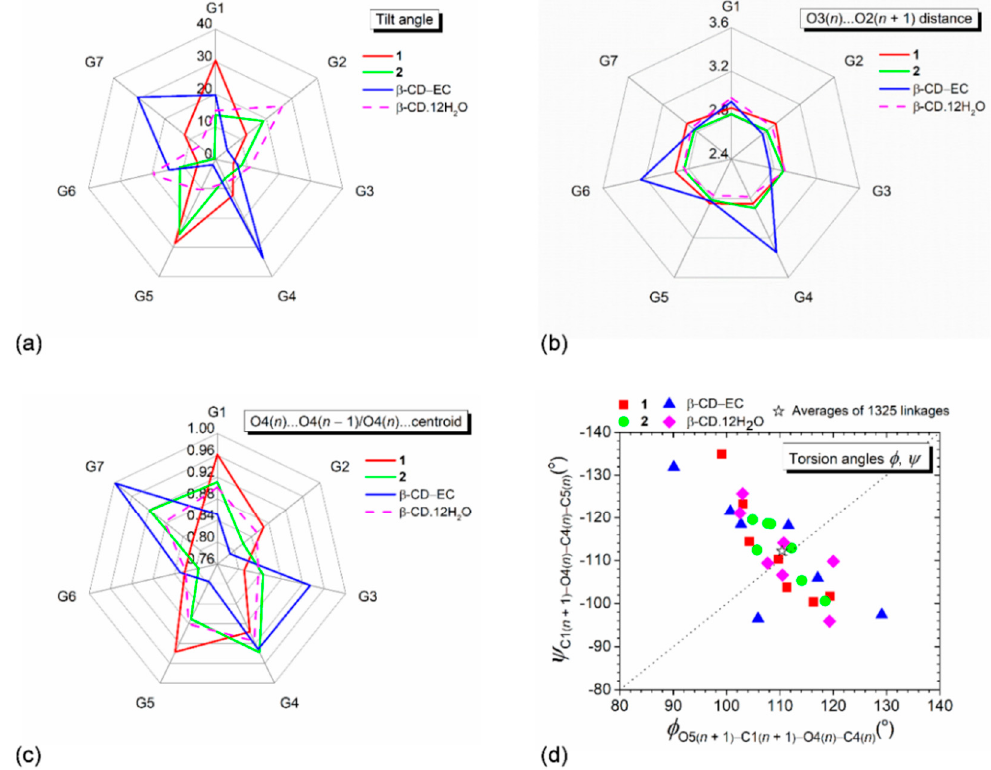
Figure 5. Radar plots of ( a ) tilt angles, ( b ) O3( n )···O2( n + 1) distances, and ( c ) O4( n )···O4( n − 1)/O4( n )···centroid distance ratios of the β -CD seven glucose units (G1–G7) affected by the inclusion of the aromatic moieties of the PRT B-ring ( 1 ) and the MPL A-ring ( 2 ). ( d ) Scatter plot of torsion angles φ , ψ around glycosidic O4. Data of the inclusion complex β -CD–(–)-epicatechin (EC) [44] and the uncomplexed β -CD·12H 2 O [45] are given for comparison. Angles and distances are in ° and Å.